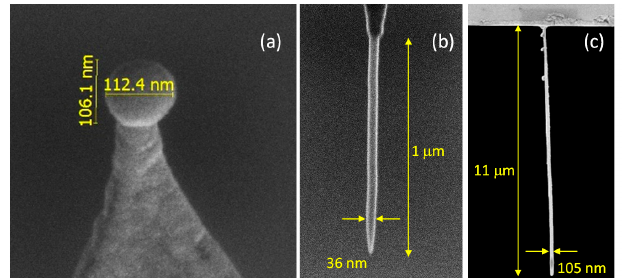
Figure 6. SEM micrographs of the three types of magnetic sensors grown by FEBID on cantilevers for scanning probe microscopy. ( a ) Co nanosphere on a cantilever for ferromagnetic resonance force microscopy. ( b ) Fe tip for magnetic force microscopy. ( c ) Long Co nanowire for scanning magnetic force sensing. ( a ) Reproduced with permission from [71]. ( c ) Reprinted with permission from